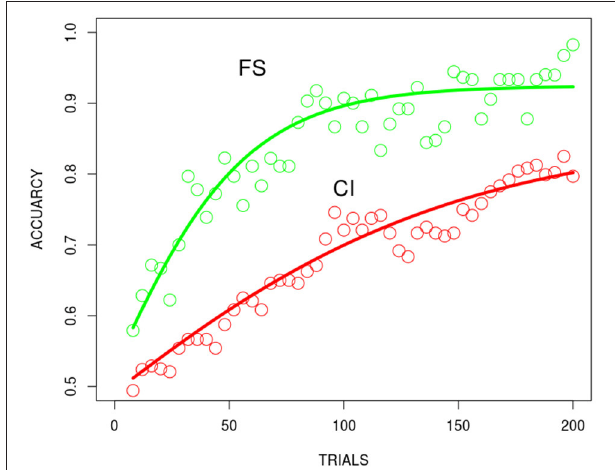
FIGURE 4 | The human behavioral result for the FS and CI conditions using the high dimensional naturalistic stimuli. Best fitting functions, hyperbolic exponential functions, (red FS, green CI). Data are binned (every 4 trials) and plotted at the midpoints of each